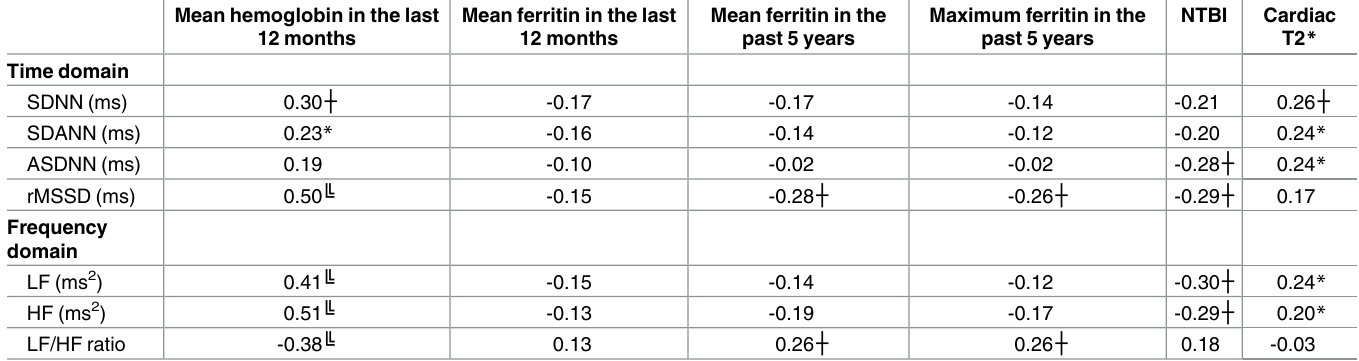
NTBI, non-transferrin bound iron; SDNN, the standard deviation of all normal sinus R-R intervals in the entire 24-hour recording; SDANN, the standard deviation of all average normal sinus R-R intervals for all 5-minute segments in the 24-hour recordings; ASDNN, the average of the standard deviation of all R-R intervals for all 5-minute segments in the 24-hour recordings; rMSSD, the root mean square of the mean of the squared differences of two consecutive R-R intervals in the 24-hour recordings; LF, low frequency power; HF, high frequency